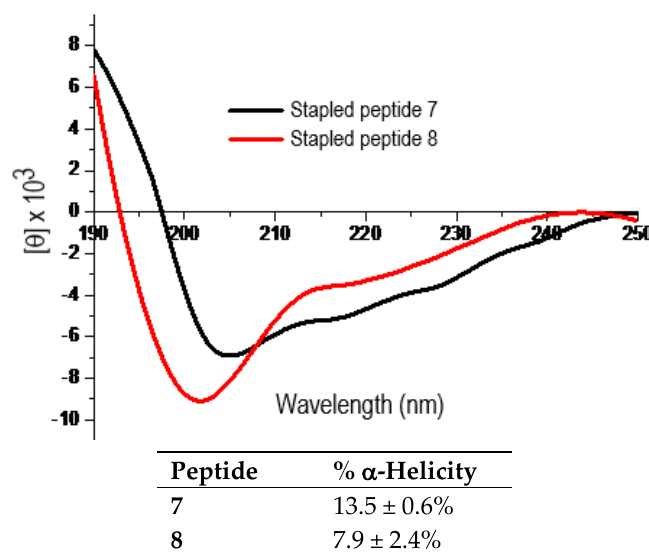
Figure 4. The representative CD spectra of the stapled peptides 7 and 8 (each at 25 µ M in ddH 2 O, 25 ◦ C) and the calculated % α -helicity values. Each peptide was assayed in duplicate at 25 µ M and / or 50 µ M in ddH 2 O. The mean residue ellipticity ([ θ ]) and the % α -helicity values were calculated in the same manner as that for peptides 2 – 6 according to the literature equations [19]. See Experimental Section for experimental details.